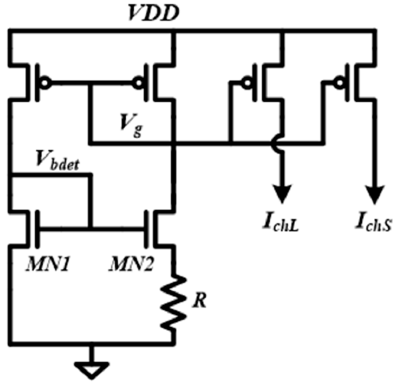
Figure 5. Schematic of the current source used for self-timed pre-charging.